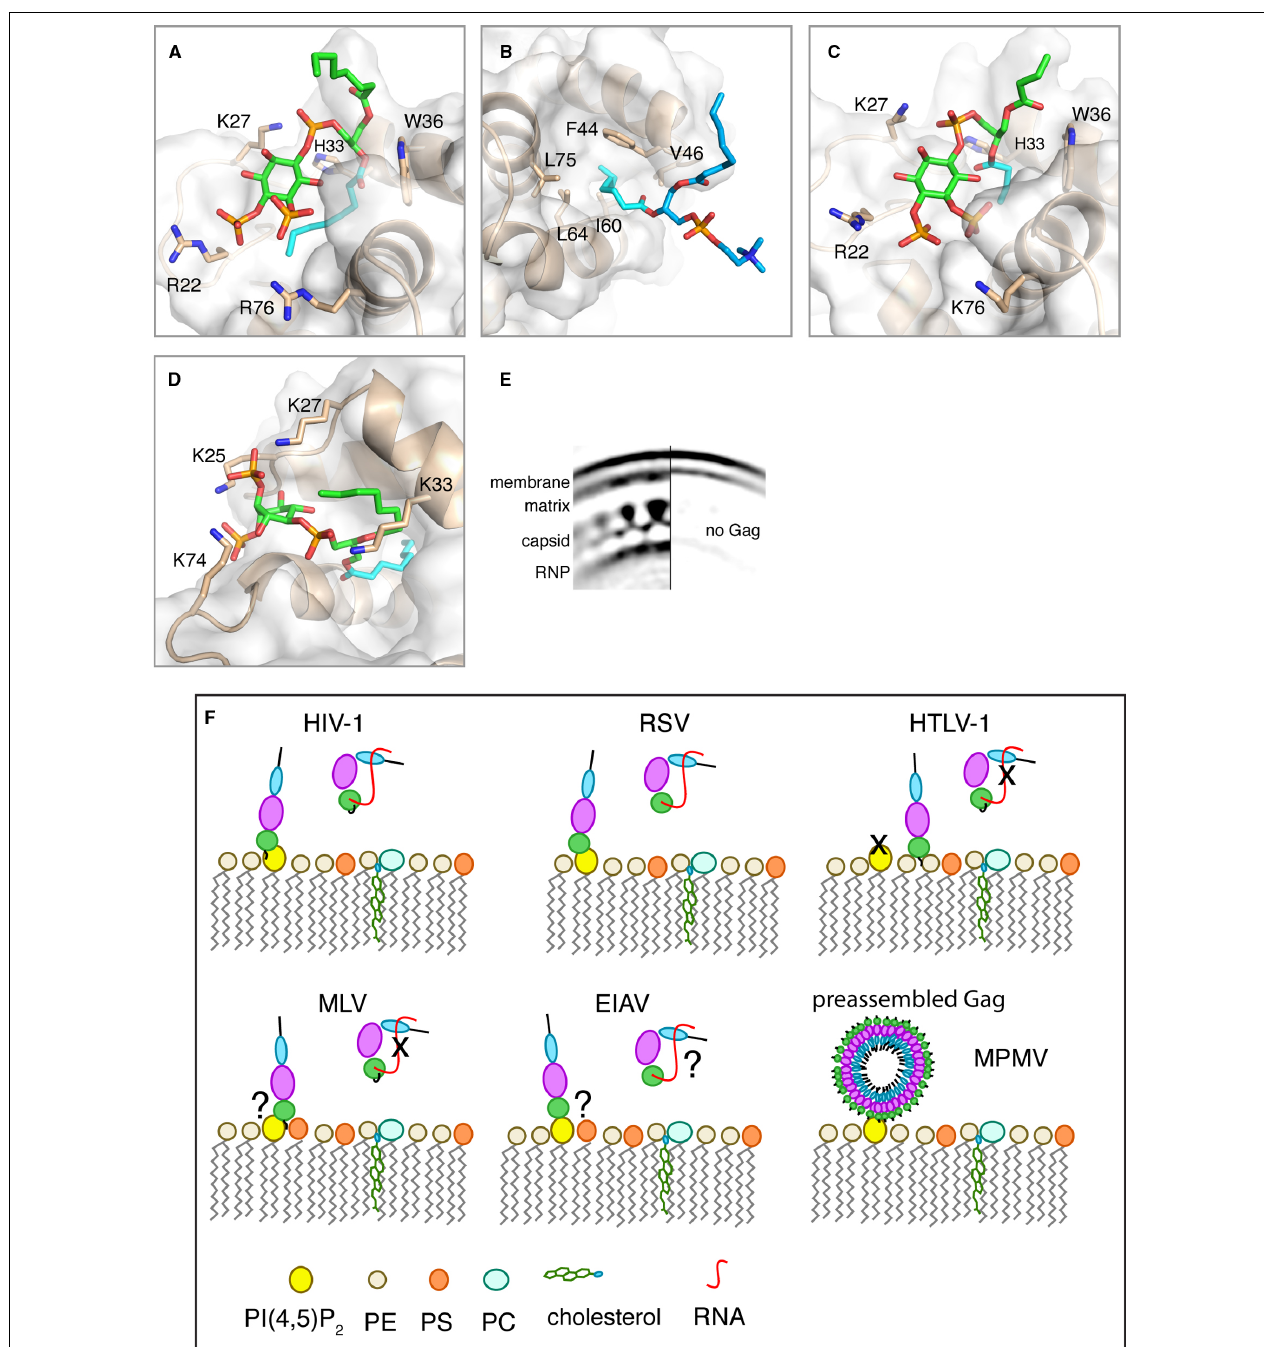
FIGURE 2 | (A–D) Close-up views of structures of HIV-1, HIV-2, and M-PMV MA proteins bound to lipids. MA proteins are shown in ribbon and surface representations with residues implicated in binding shown as sticks. Phospholipids are shown as green [PI(4,5)P 2 ] or blue (PC) sticks and their acyl chains involved in binding are shown in cyan. (A) HIV-1 myr( − )MA bound to di-C 8 -PI(4,5)P 2 (PDB ID: 2H3V). (B) HIV-1 myr( − )MA bound to di-C 8 -PC (PDB ID: 2LYA). (C) HIV-2 MA bound di-C 4 -PI(4,5)P 2 (PDB ID: 2K4I). (D) M-PMV MA bound to di-C 8 -PI(4,5)P 2 structure provided by Prchal et al. (2012). (E) Cryoelectron microscopy reconstruction of HIV-1 immature particle in a section with (left) or without (right) Gag polyprotein present. Used with